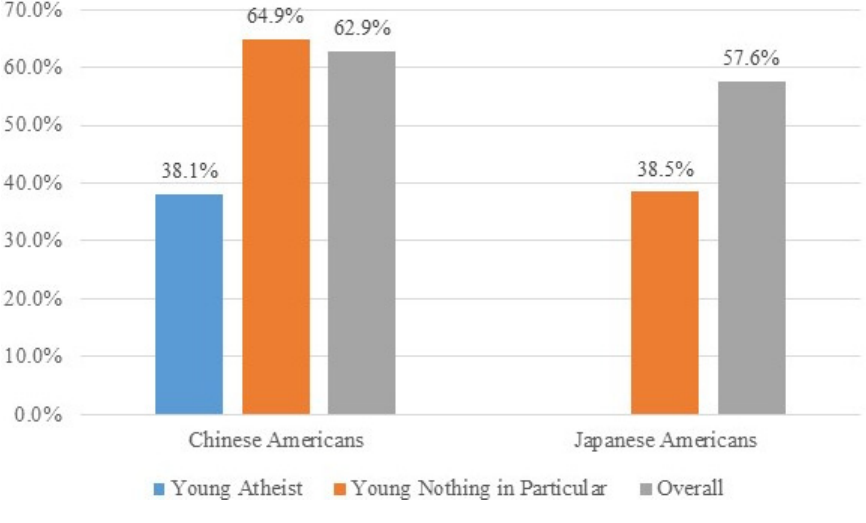
Figure 15. Values parental influence in